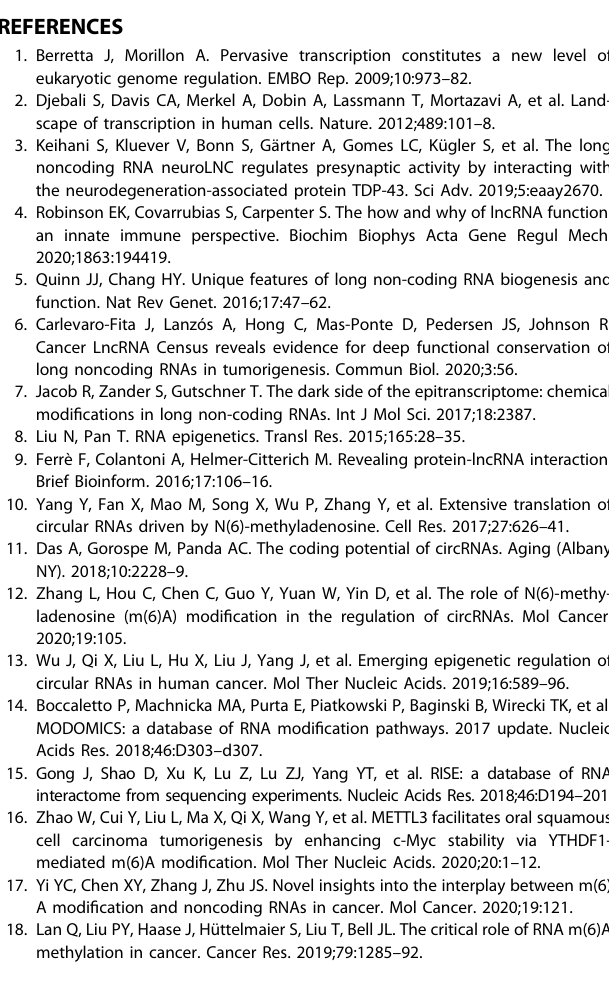
RNA pieces are always recognized and m 6 A is noticeably expressed in the 3 ′ -UTR near mRNA stop-codons and long internal exons in different cell/tissue special sites [24]. Thus, biological actions result in the particular transcriptome topology of m 6 A. With the supplementary modi fi cation of m 6 A, the functions of lncRNAs and circRNAs encompass an abundant diversity of signi fi cant biological phenomena, including the imprinting of genomes [4], the sponging or stabilization of miRNAs or proteins, and the upregulation or downregulation of related genes. Furthermore, ncRNAs can feedback to af fl ict the effect of m 6 A modi fi cation, then complicating the outcomes of pathophysiological activities in vitro and in vivo. Regardless of how many DNAs, RNAs, proteins, and their complexes are involved, there still are only four steps required from genome to proteome: RNA production, RNA degradation, protein production, and protein degradation. Unfortunately, because of the limits of methods and other factors, we still only reveal the tip of the iceberg in the physiological and pathological activities of cells and organisms. There are a bunch of ncRNAs whose functions and interactions modulated by m 6 A modi fi ca- tions need more characterization studies and detections to be recognized, which may be the focus of future studies. In summary, with the deeper investigations into lncRNAs, circRNAs, and m 6 A, there may be some novel therapies, effective strategies, or sensitive detection methods to cure or screen for cancers, especially in combination with